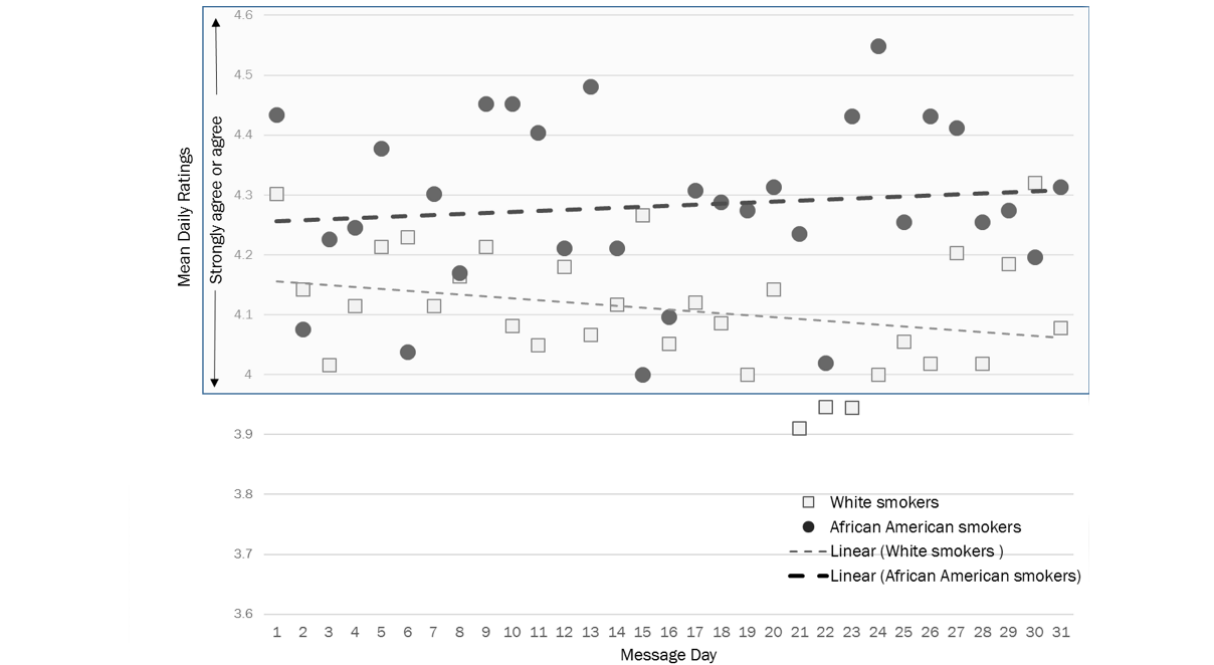
Figure 2. African American and white people who smoke mean message ratings over